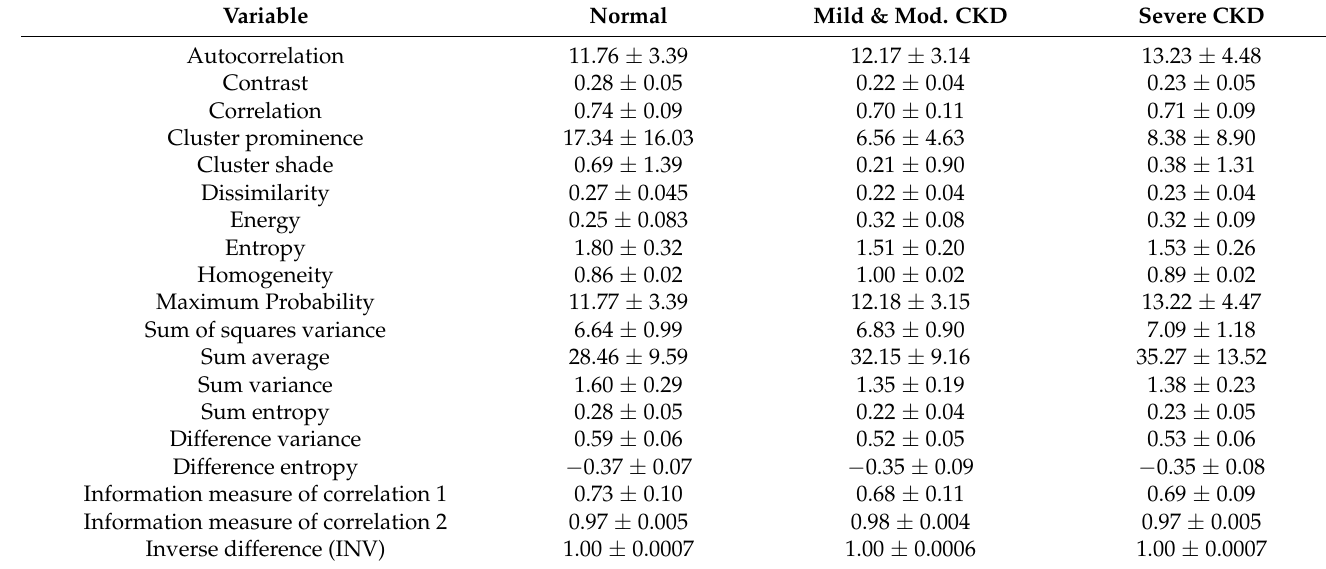
Table 6. Values of GLCM features of the medulla (mean ± STD).